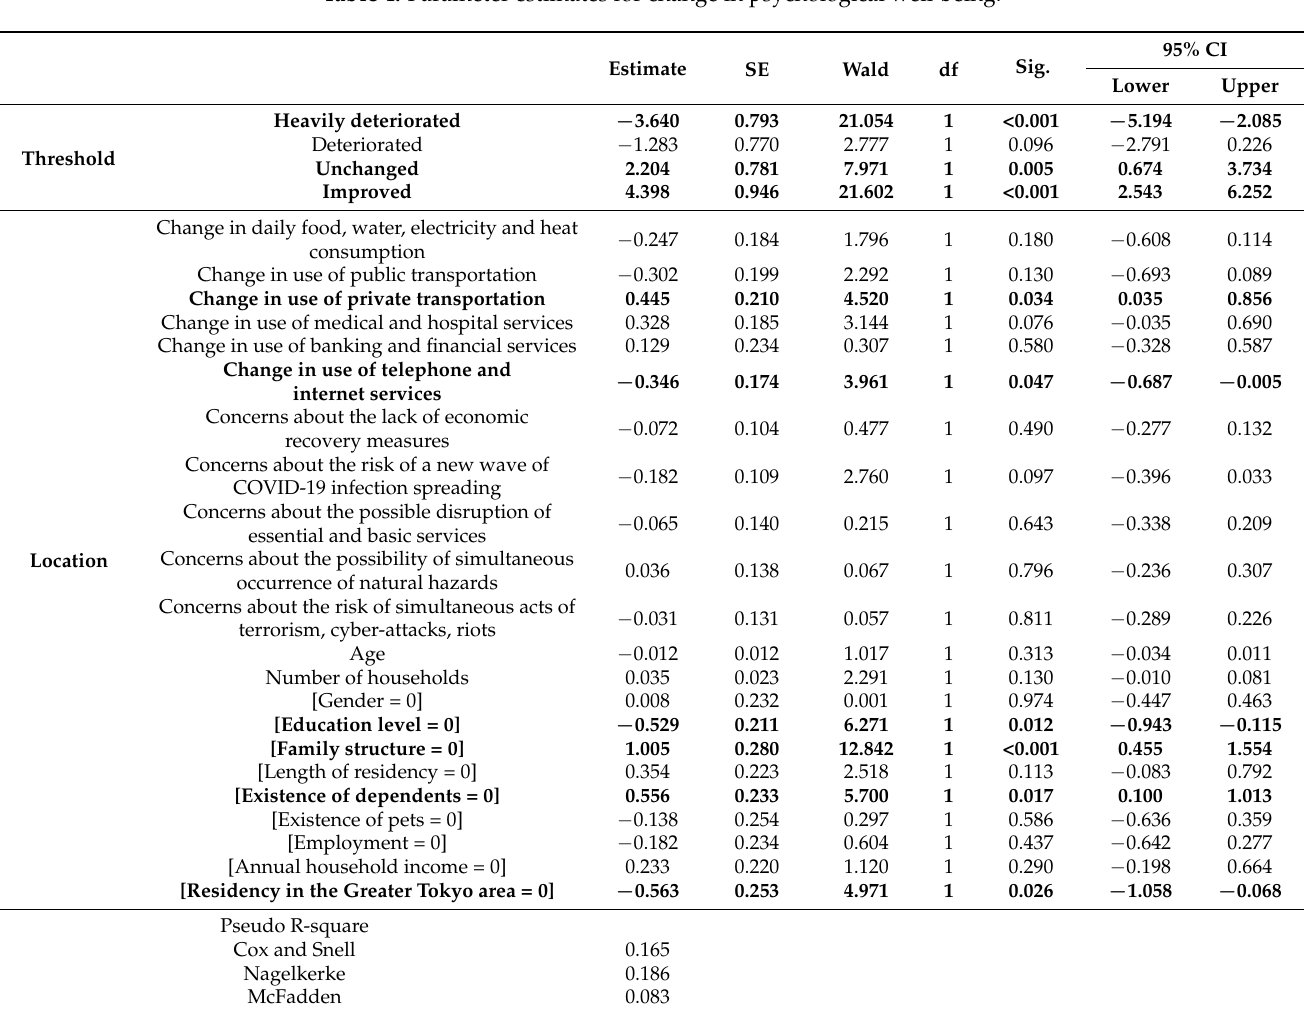
Table 4. Parameter estimates for change in psychological